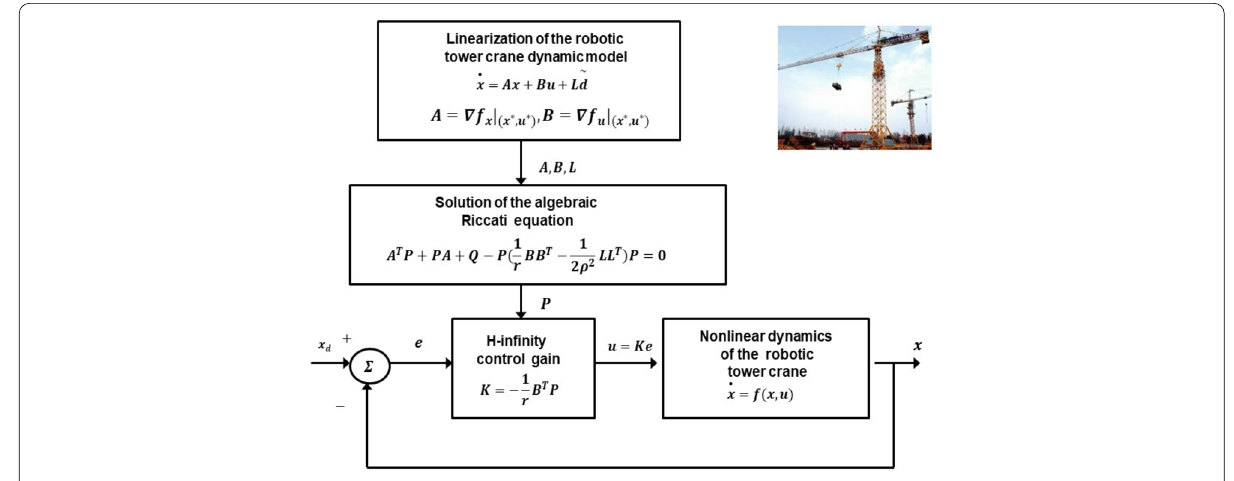
Figure 2 Diagram of the control scheme for the 4-DOF underactuated tower